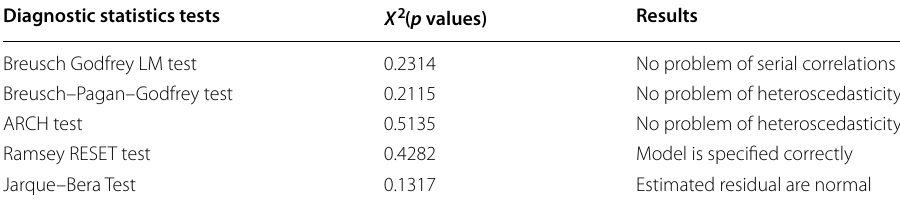
Table 7 Diagnostic statistics